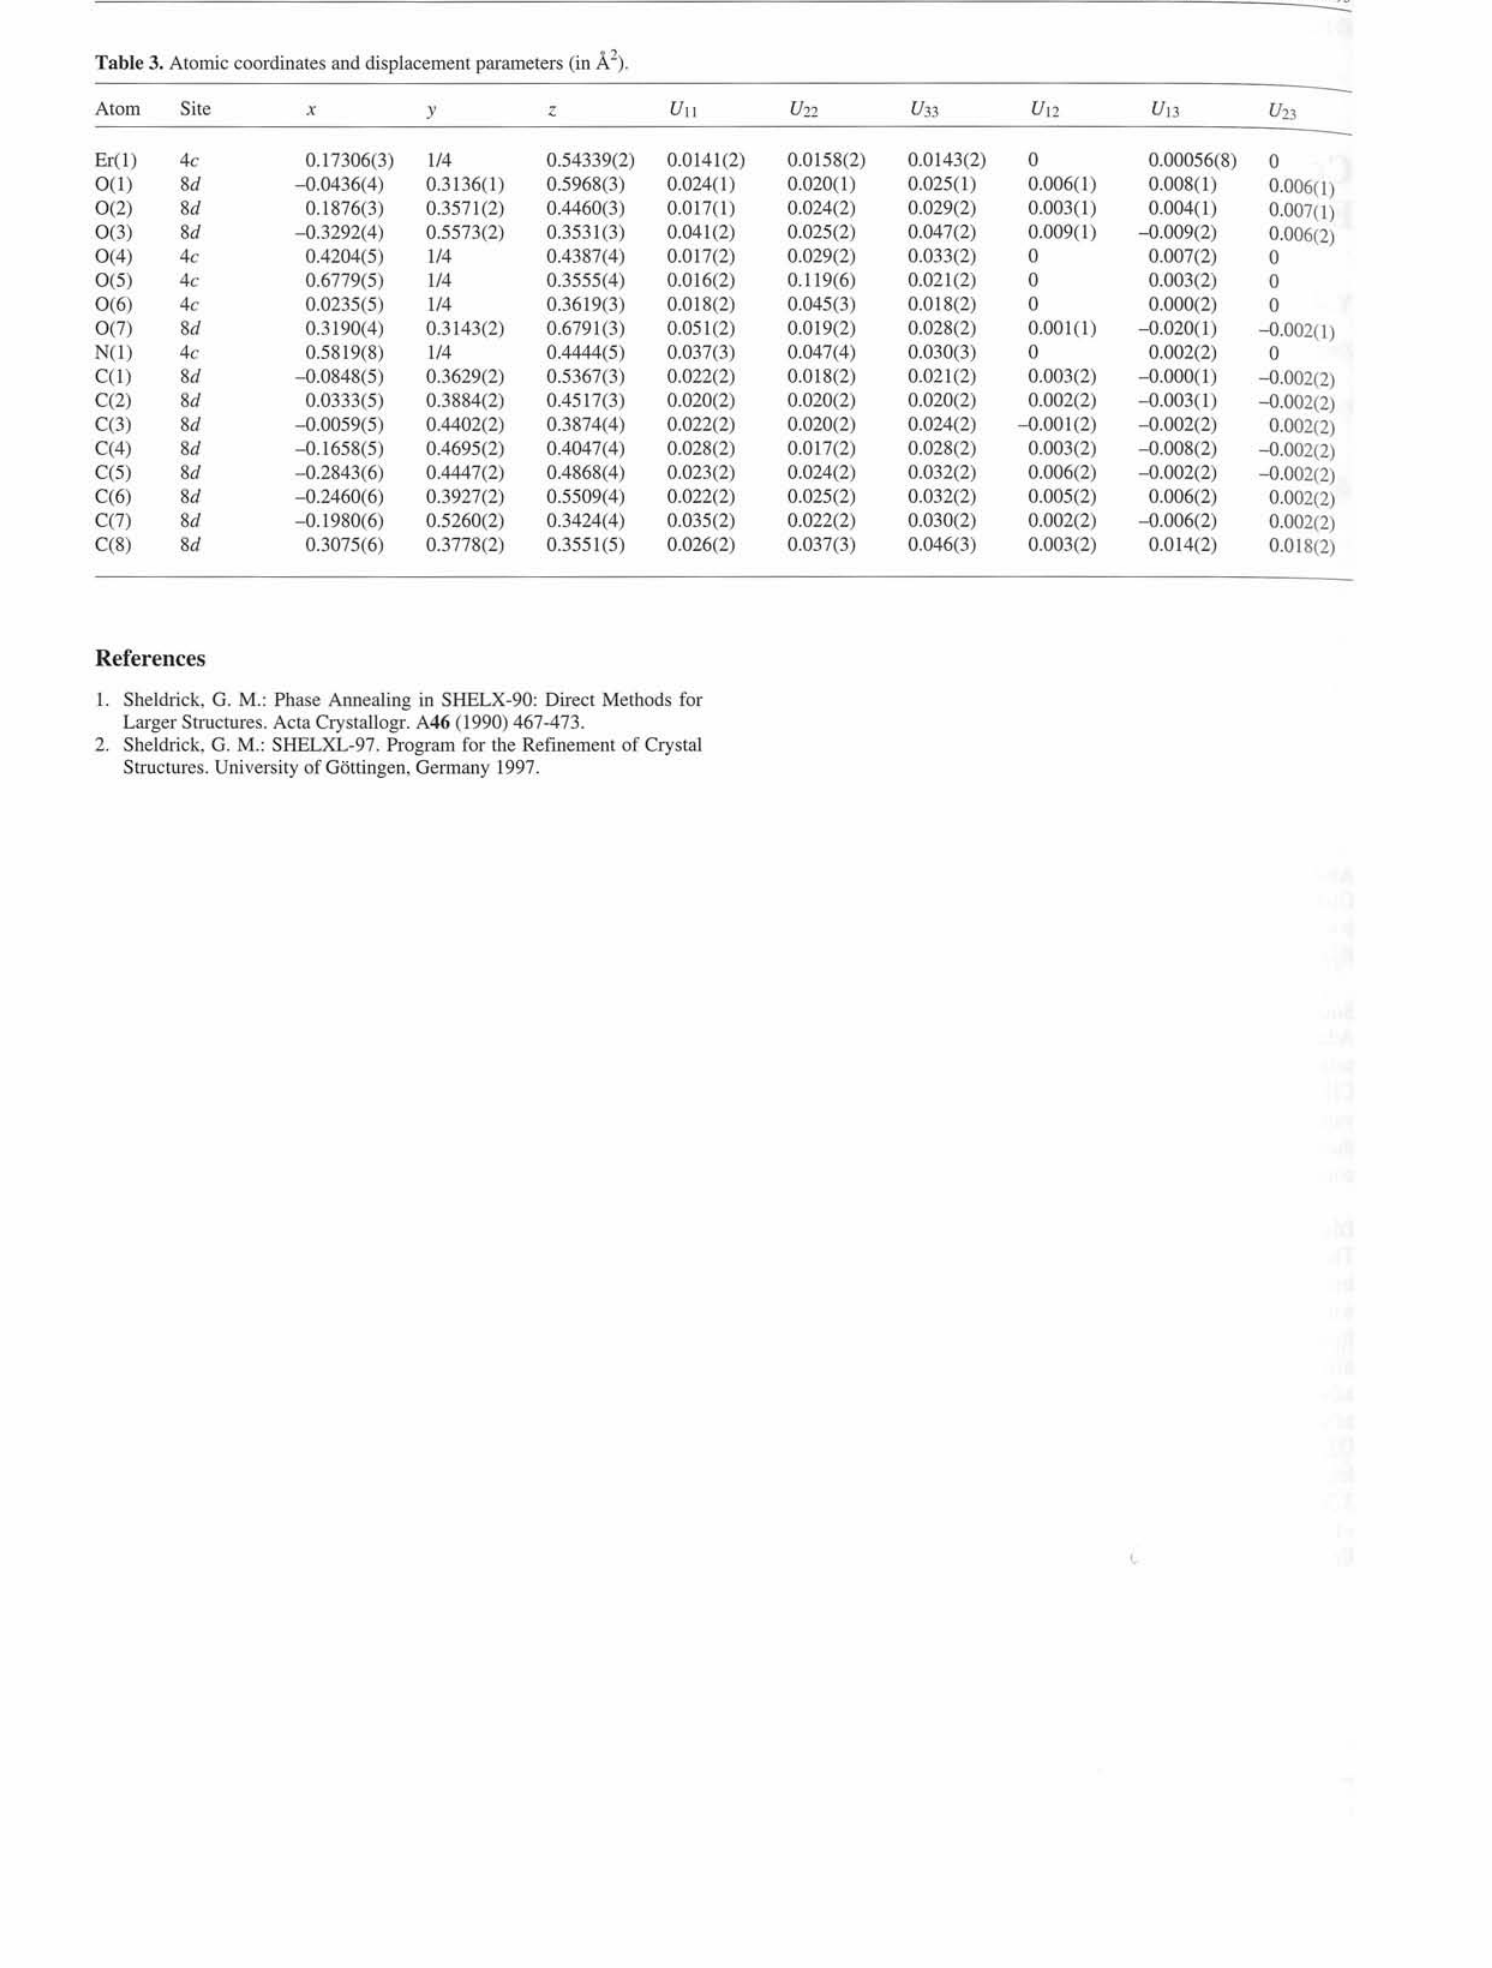
Ο Ί Table 3. Atomic coordinates and displacement parameters (in